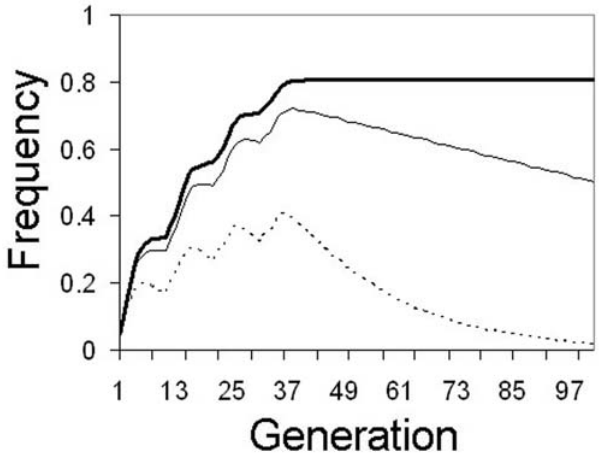
Figure 4. Continuous moderate release. Changes in transgene frequency with a 5% continuous release rate per generation of mosquitoes homozygous for a transgene at 4 unlinked loci (8 copies/ genome). Thick solid line: no fitness cost ( F =1.0), thin solid line: 1% fitness cost/insert ( F =0.99), thick dotted line: 5% fitness cost/insert ( F =0.95), thin dotted line: 10% fitness cost/insert ( F